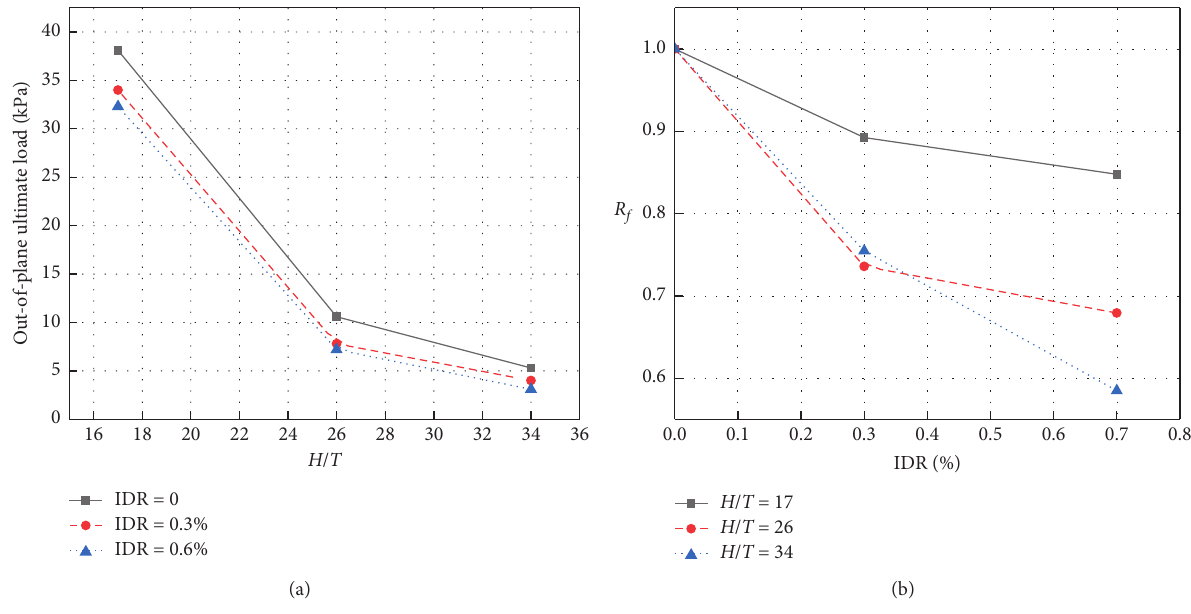
Figure 12: The effect of (a) slenderness ratio and (b) IP damage on the OOP strength of the infill wall.